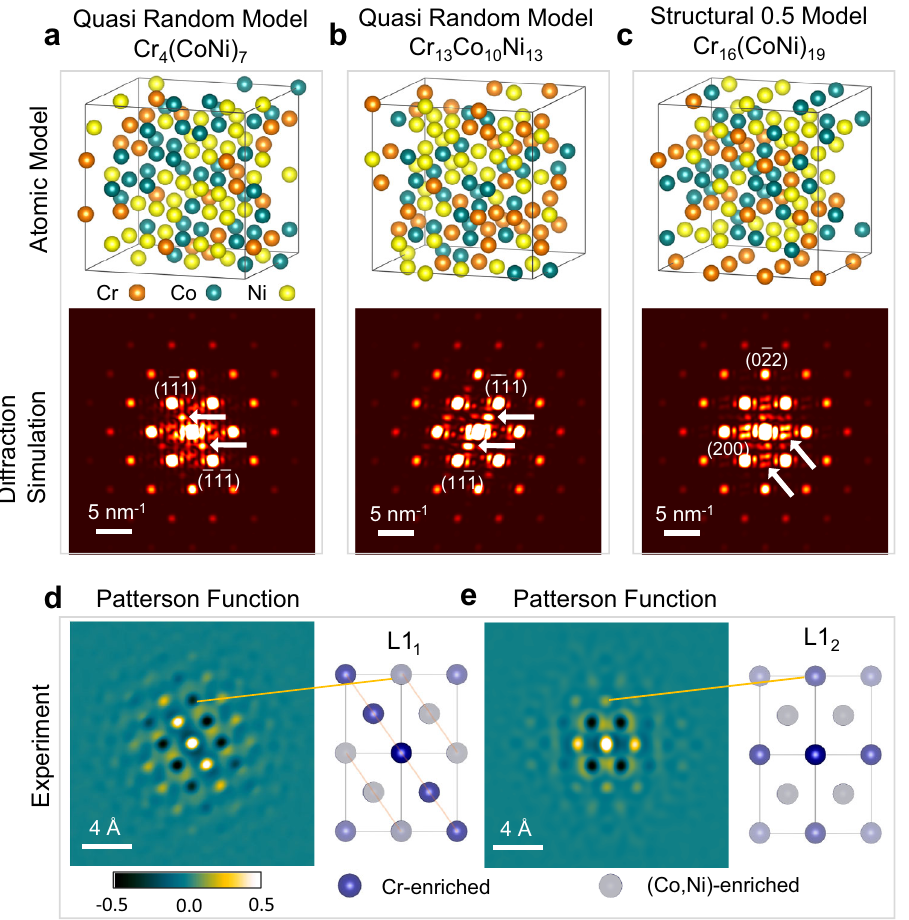
Fig. 4 | Short-range ordering in CrCoNi. Atomic structural models from fi rst- principlescalculationswith( a )and b fromquasi-randomcon fi gurationsand c from CSRO con fi guration (Structural 0.5 model) 23 and their corresponding simulated diffractionpatterns. d and e areexperimentaltwo-dimensionalPattersonfunctions